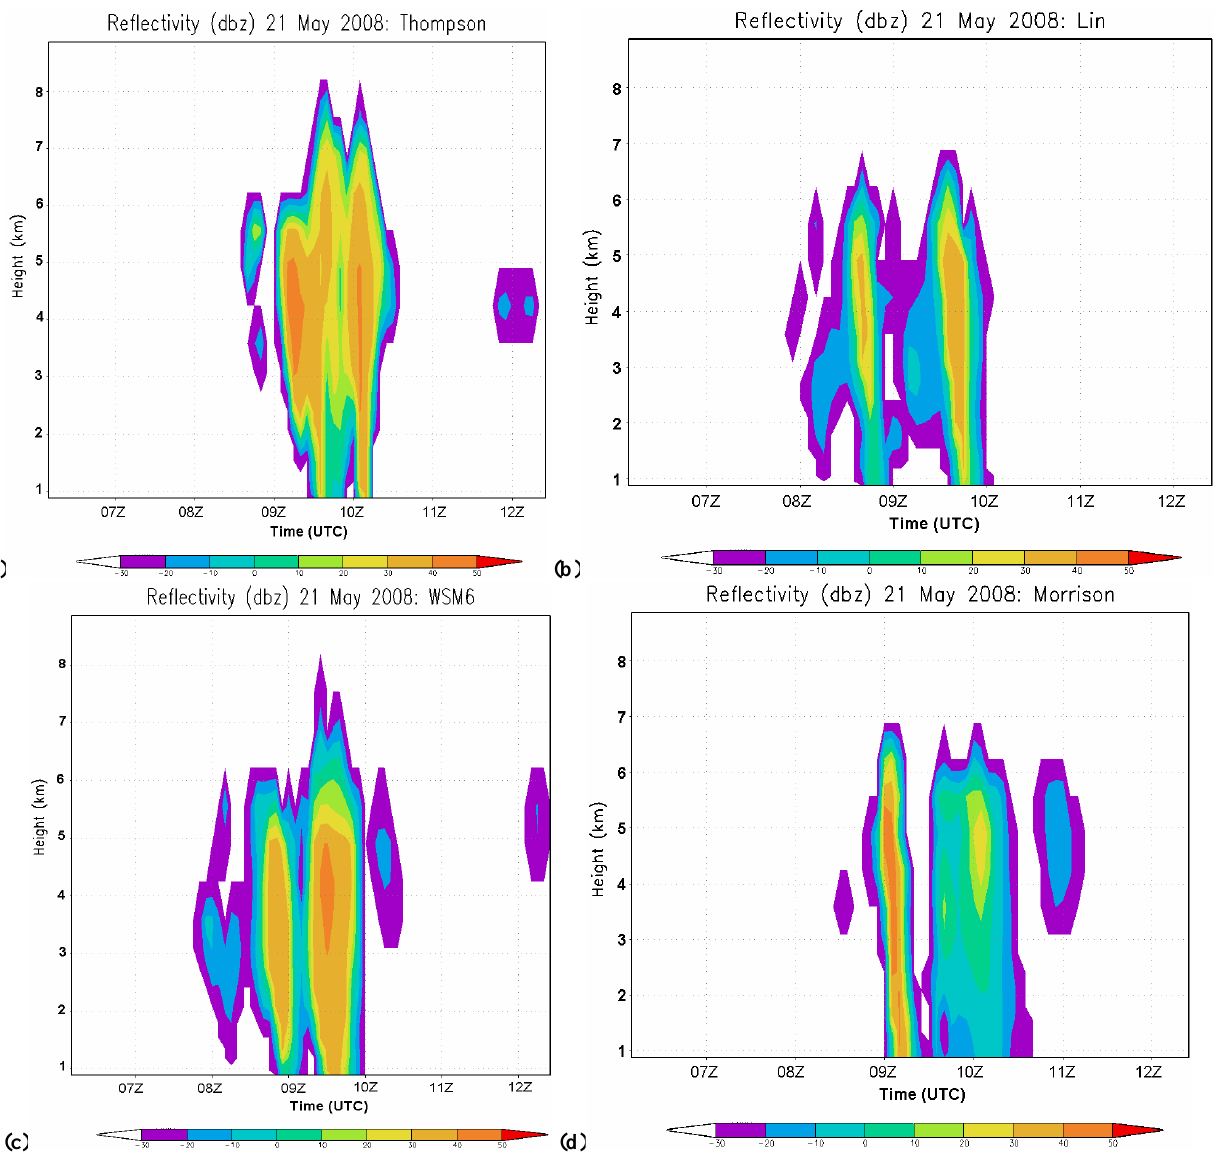
Fig. 11. Vertical profile of reflectivity (dbz) at Gadanki simulated by the model with four different MP Schemes (a) Thompson, (b) Lin, (c) WSM6, and (d)